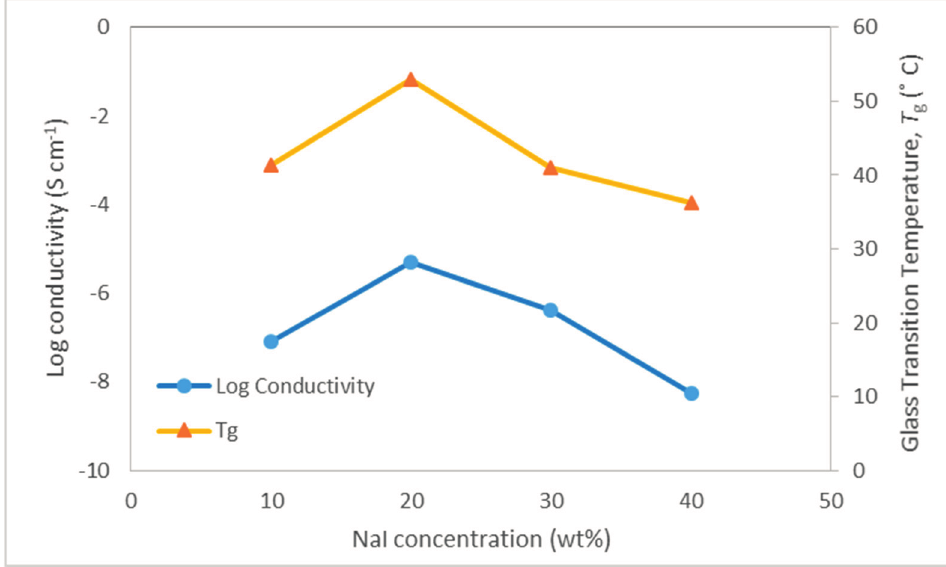
Figure 3. Log conductivity with the glass transition temperature ( T g ) of P(MMA- co -EMA) with various concentrations of